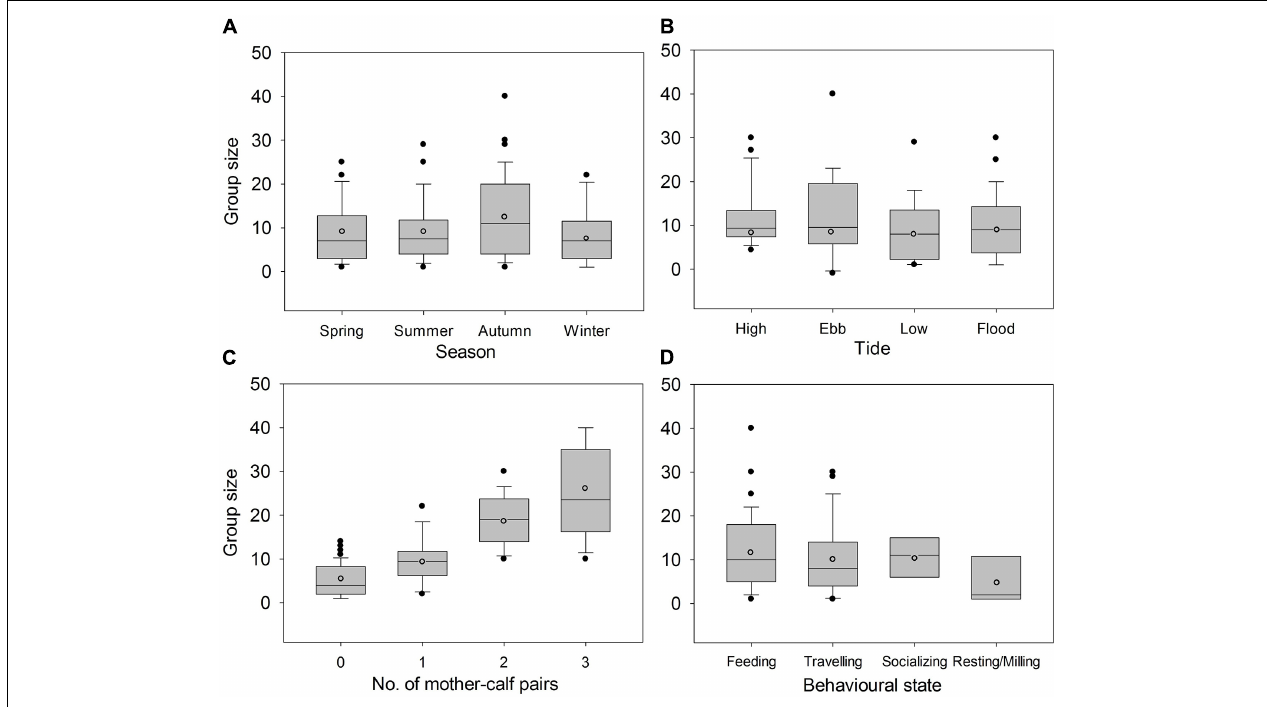
FIGURE 5 | Boxplots of group sizes of Indo-Pacific humpback dolphins in the eastern waters of Zhanjiang, China, categorized by (A) season, (B) tide, (C) number of mother-calf pairs, and (D) behavioral state. Mean values (open circles), median values (black horizontal line), lower (25%) and upper (75%) quartiles, and outlier values (black dots) were illustrated.